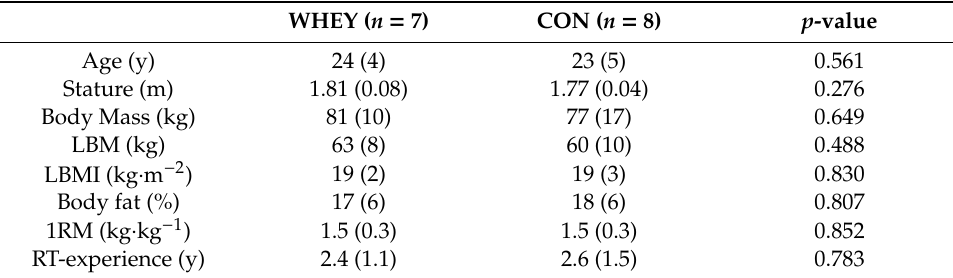
Table 1. Participant Baseline